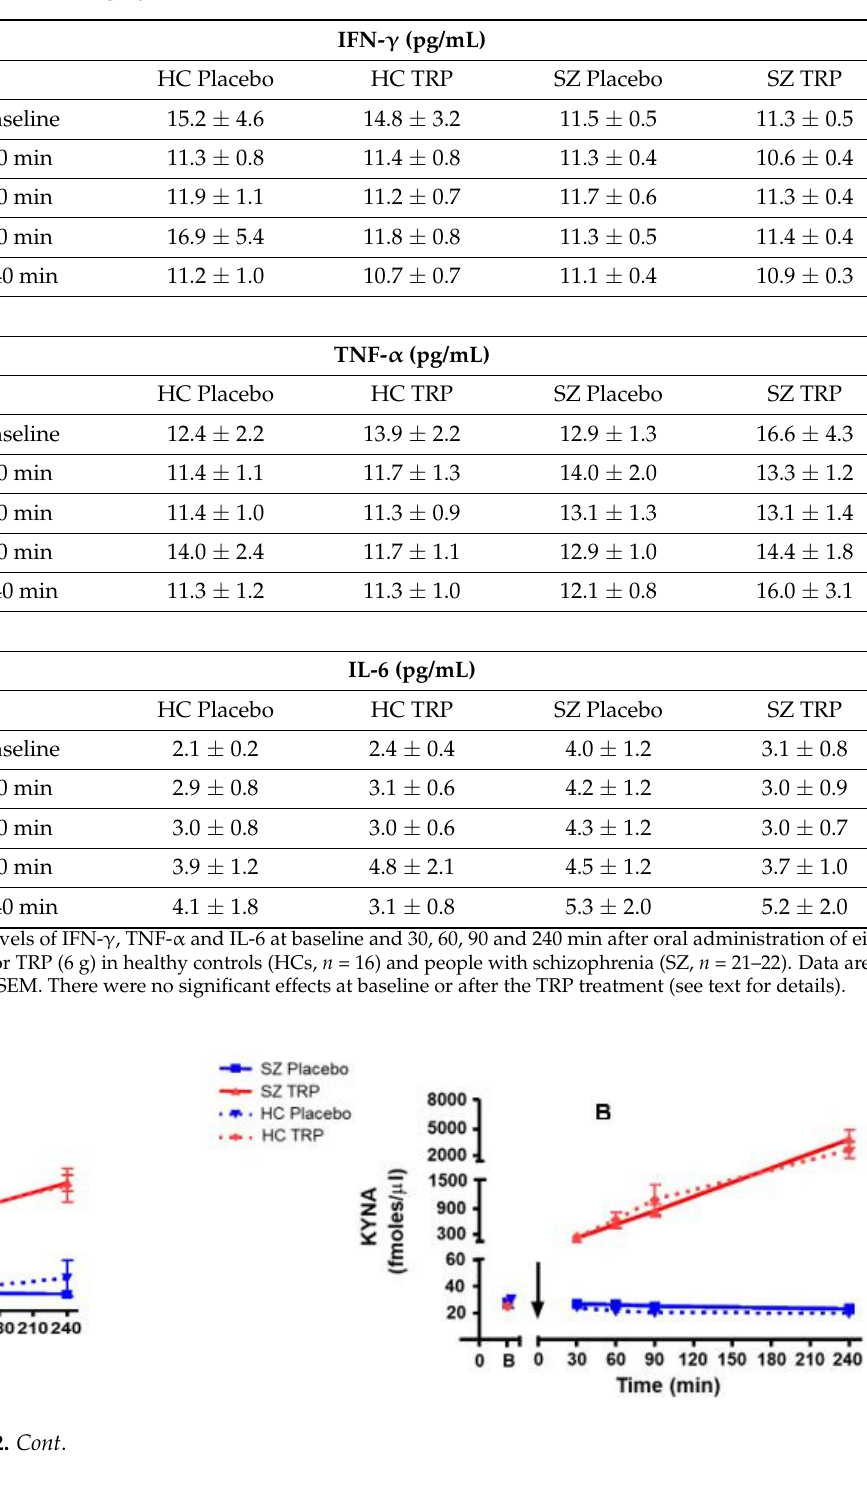
Table 1. Circulating